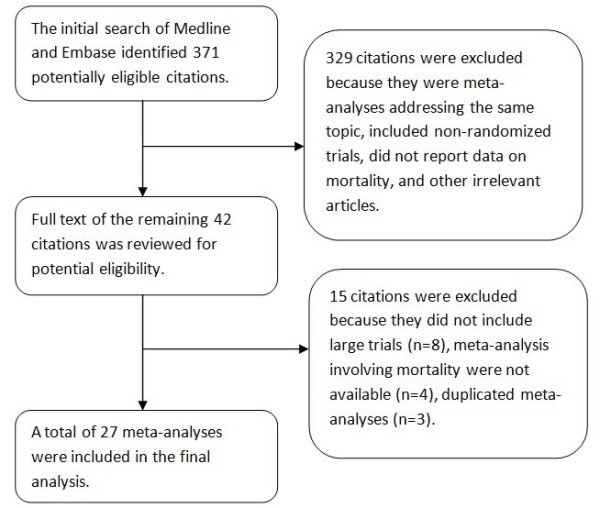
Flow chart showing the selection of studies.